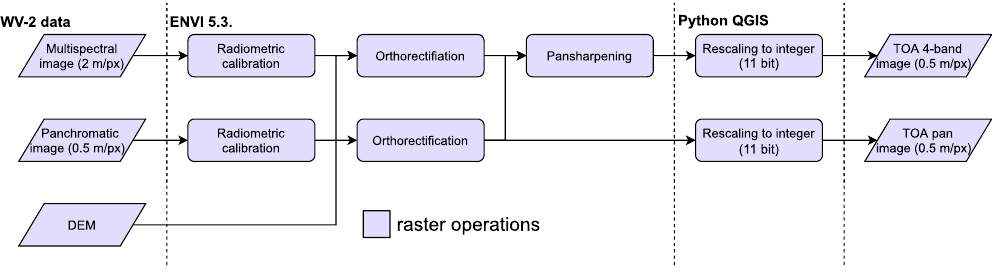
Figure 2. Procedure of pre-processing applied to the WV-2